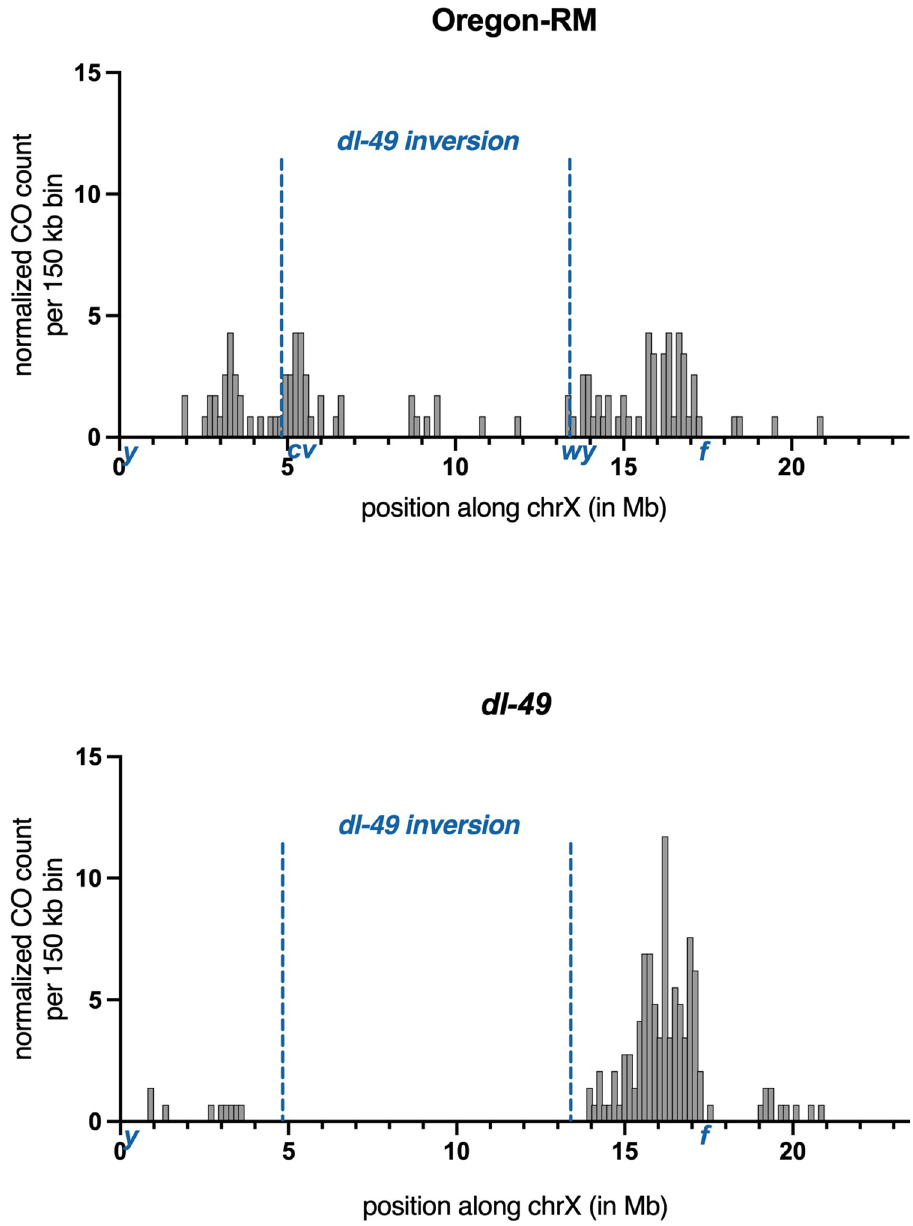
Fig 3. Location and frequency of COs recovered in Oregon-RM and dl-49 heterozygotes. When selecting for COs between y and cv or wy and f , we recovered chromosomes that had two COs, one of which was between cv and wy . These are shown in the figure, but the COs were not included in any analyses. CO counts were normalized to sample size by dividing the number of COs per interval by the total number of COs. 95% confidence intervals were calculated and can be found in S1 File. In Oregon-RM, CO distribution between the dl-49 breakpoint and f are not correlated with distance (Spearman’s rank correlation, r = 0.18, p = 0.35). In dl-49 heterozygotes, CO distribution between the dl- 49 breakpoint and f are correlated with distance (Spearman’s rank correlation, r = 0.47, p =